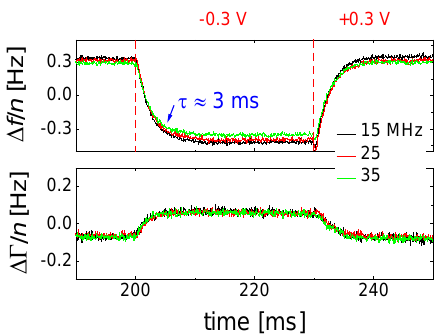
Figure 8. Shifts in frequency and bandwidth obtained in a modulation experiment, using the fixed-frequency-drive mode (FFD mode). The stimulus was the electrical potential of the front electrode, varied between +0.3 V and − 0.3 V vs. a platinum pseudo-reference electrode. The sample was an electrochemically inert electrolyte. After accumulation overnight, the noise was around 20 mHz, based on a time interval of 100 µs per data point.